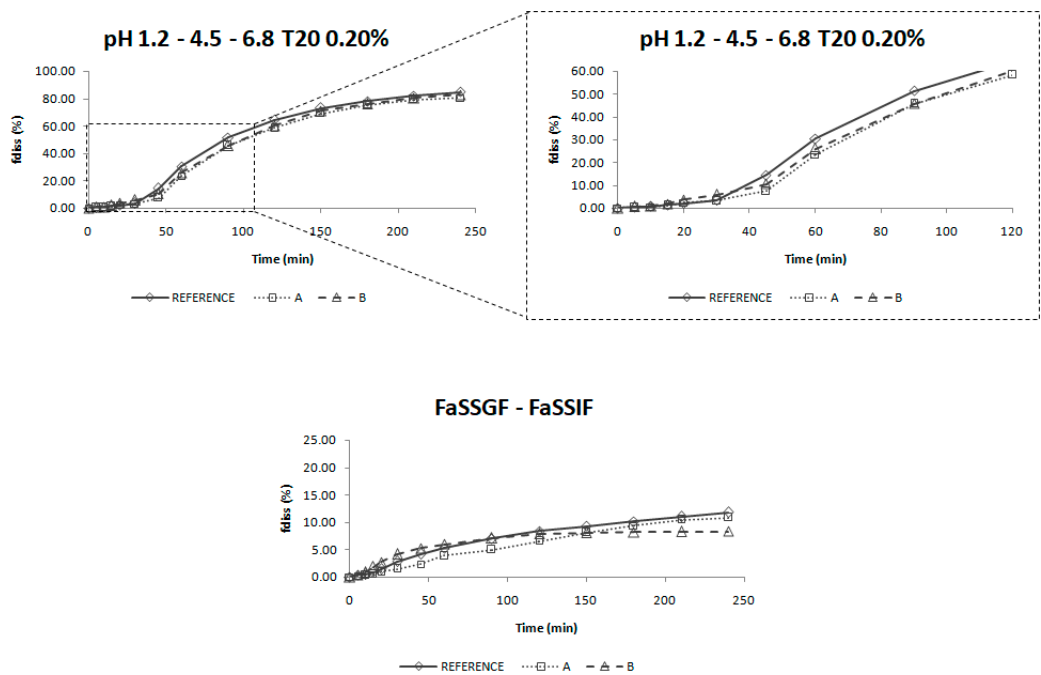
Figure 5. Dissolution profiles of the three products of candesartan cilexetil (Reference, Product A and Product B) obtained in di ff erent conditions in USP IV apparatus. In the bottom panel, the Y-axis is limited to 25% to allow a better visualization of the results obtained. T20 = Tween 20, f diss = fraction